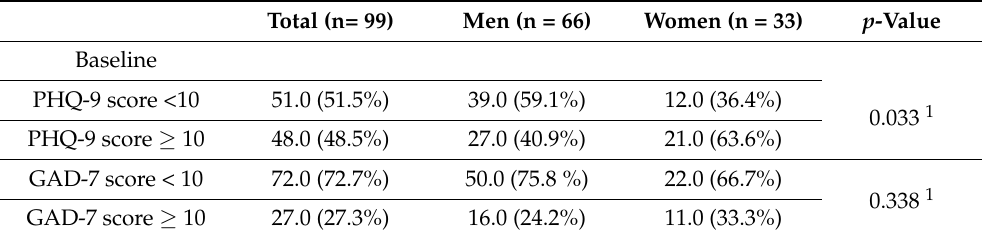
Table 2. Clinical depression and anxiety measured by PHQ-9 and GAD-7 before initiating CPAP therapy, after 6 months and 1 year of